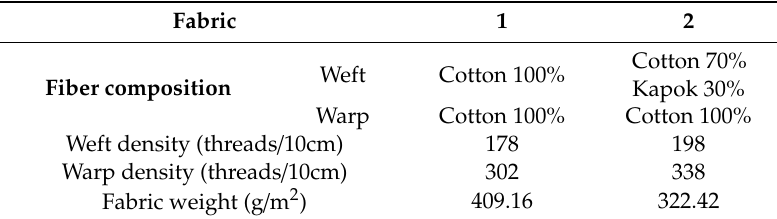
Table 1. The composition and specification of denim